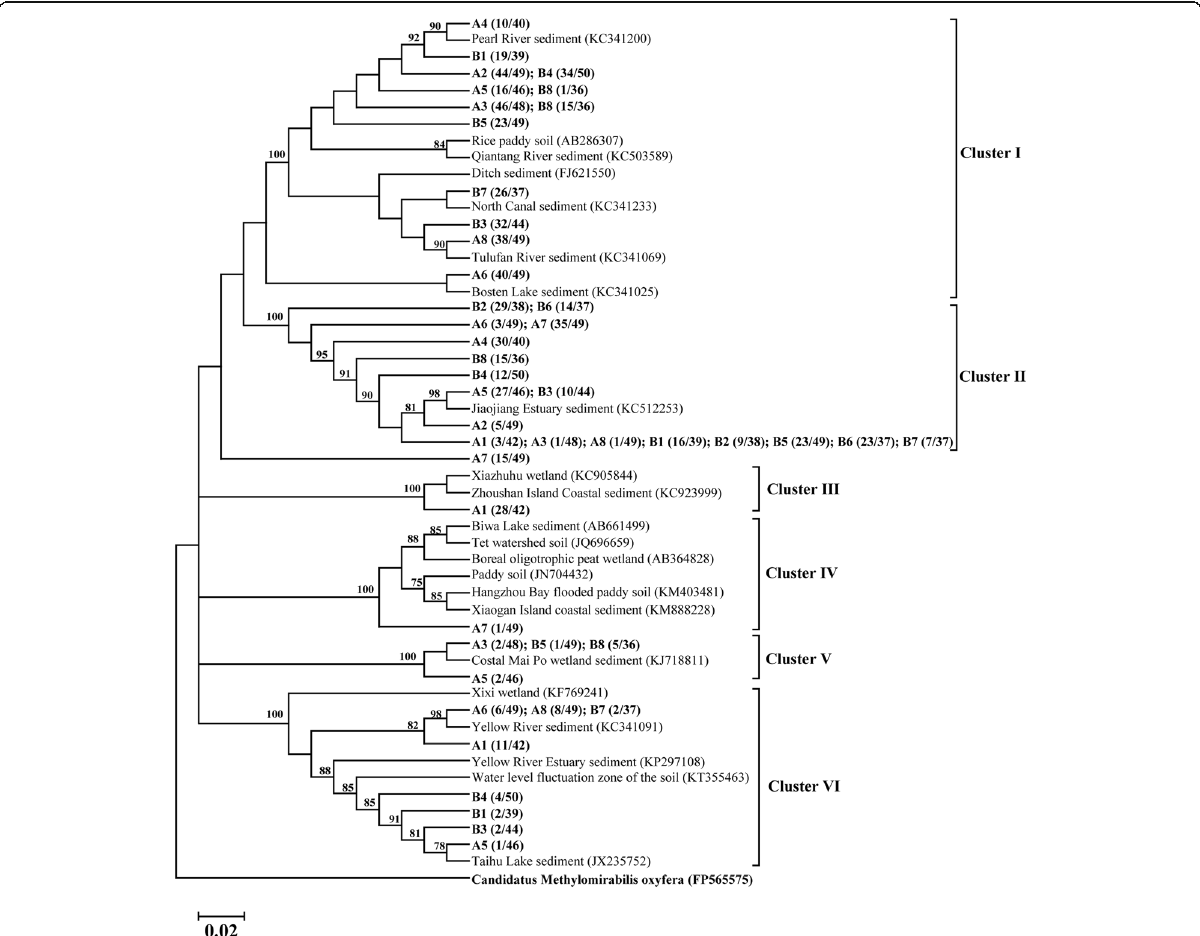
Fig. 4 Neighbor-joining phylogenetic tree showing the phylogenetic affiliations of 16S rRNA genes. Numbers in parentheses are the number of clones within this OUT. GenBank accession numbers are shown following sequences from other studies. The letter A represents 16S rRNA genes in summer, and the letter B represents the genes in winter. The bootstrap values were based on 1000 replicates; the scale bar indicates the number of nucleotides substitutions per homologous